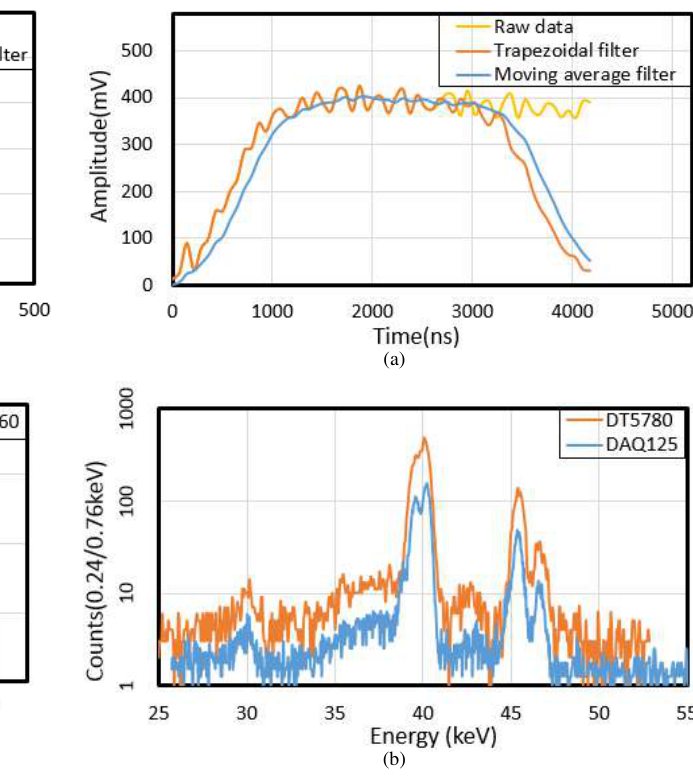
Fig. 6. Radiation pulse(a) and γ-rays spectrum(b) with a CeBr 3 detector.